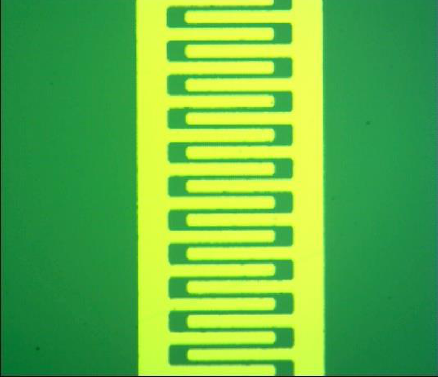
Fig.2 Optical micrograph of IDE Figure 2. Optical micrograph of the IDE. Figure 2. Optical micrograph of the